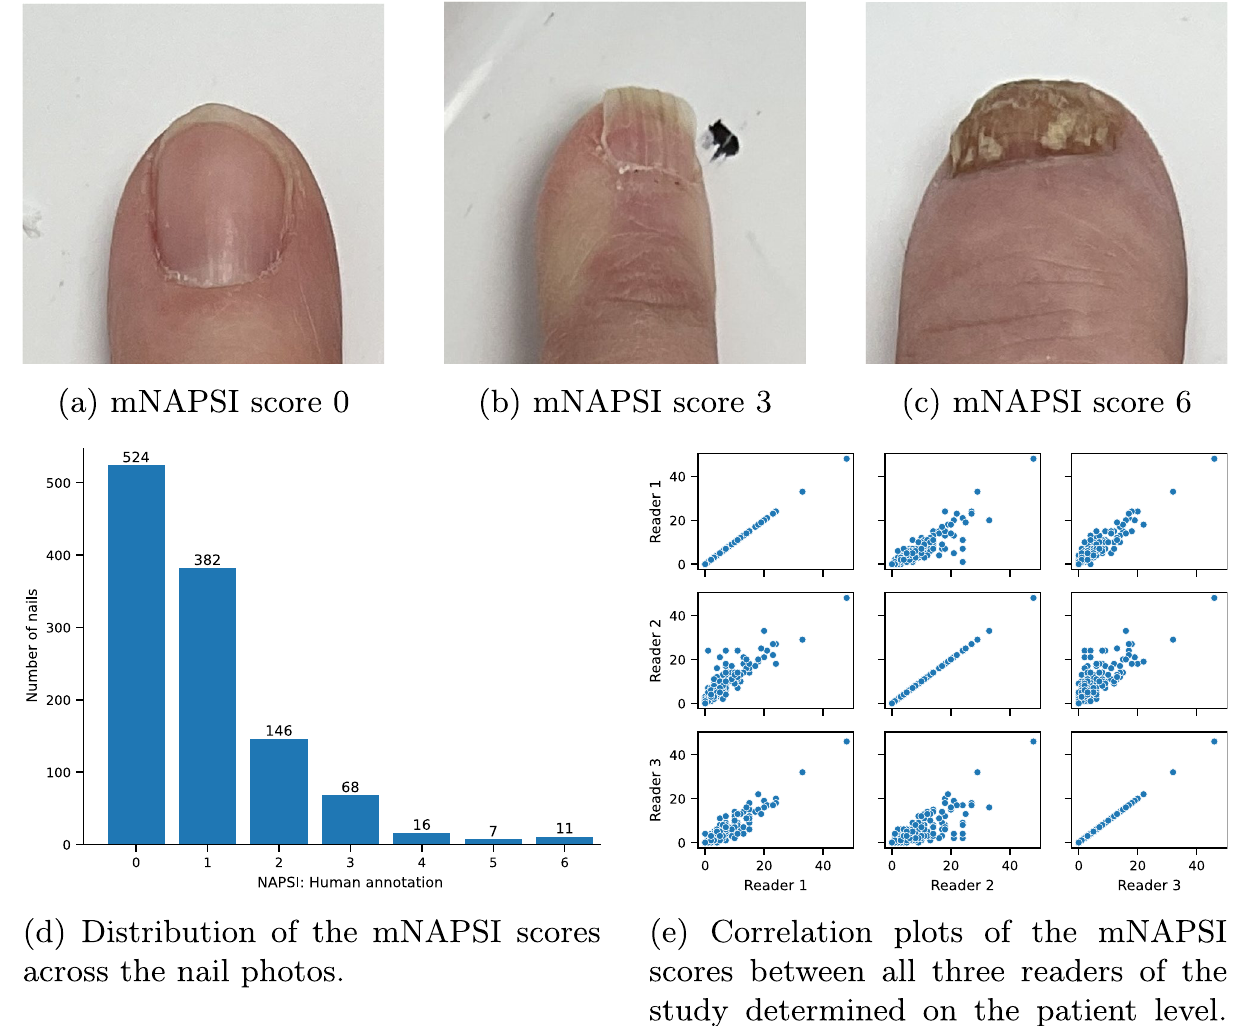
Figure 2. Overview of the acquired dataset including exemplary nail photos and corresponding mNAPSI grades, the distribution of the mNAPSI grades, and the agreement of all